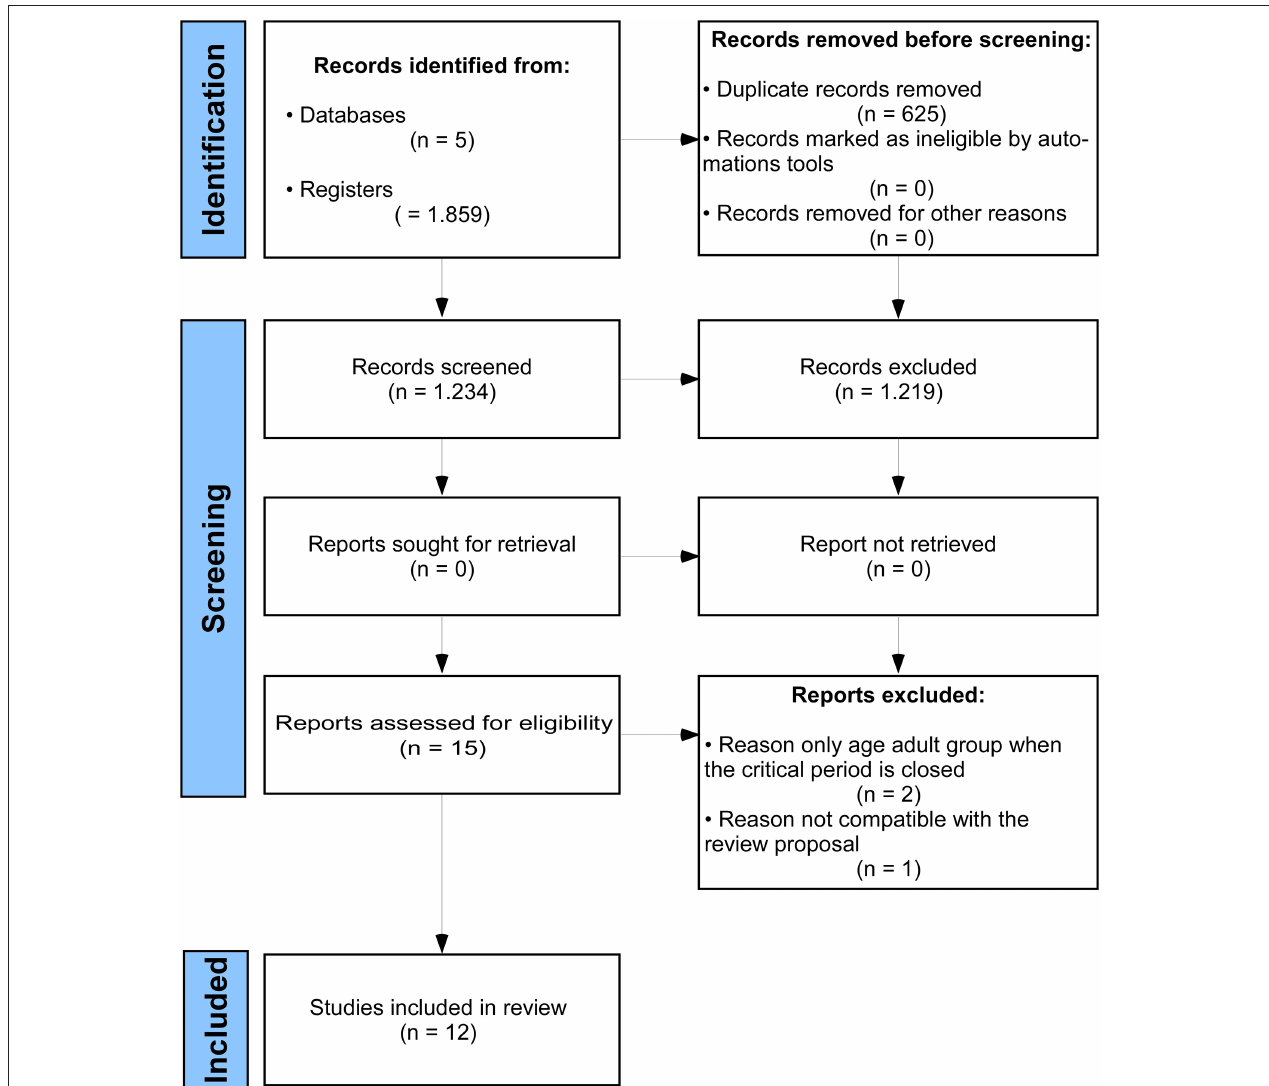
FIGURE 1 | The Preferred Reporting Items for Systematic Reviews and Meta-Analyses (PRISMA) flow